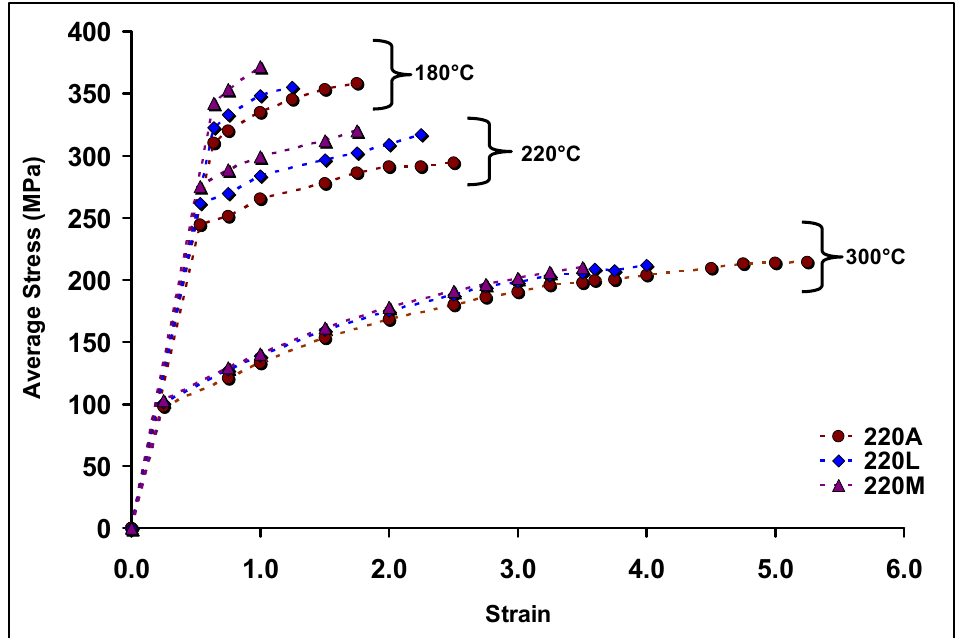
Figure 5. Average stress–strain curves for alloys 220A, 220L, and 220M aged at 180 °C, 220 °C, and 300 °C. All tensile bars were aged for 10 h.